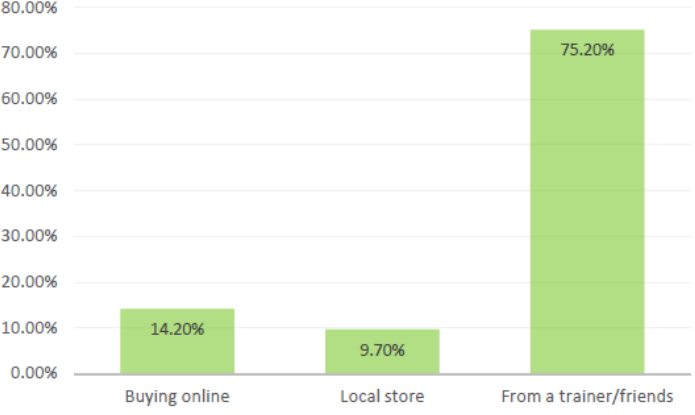
Figure 3. Sources of steroids.